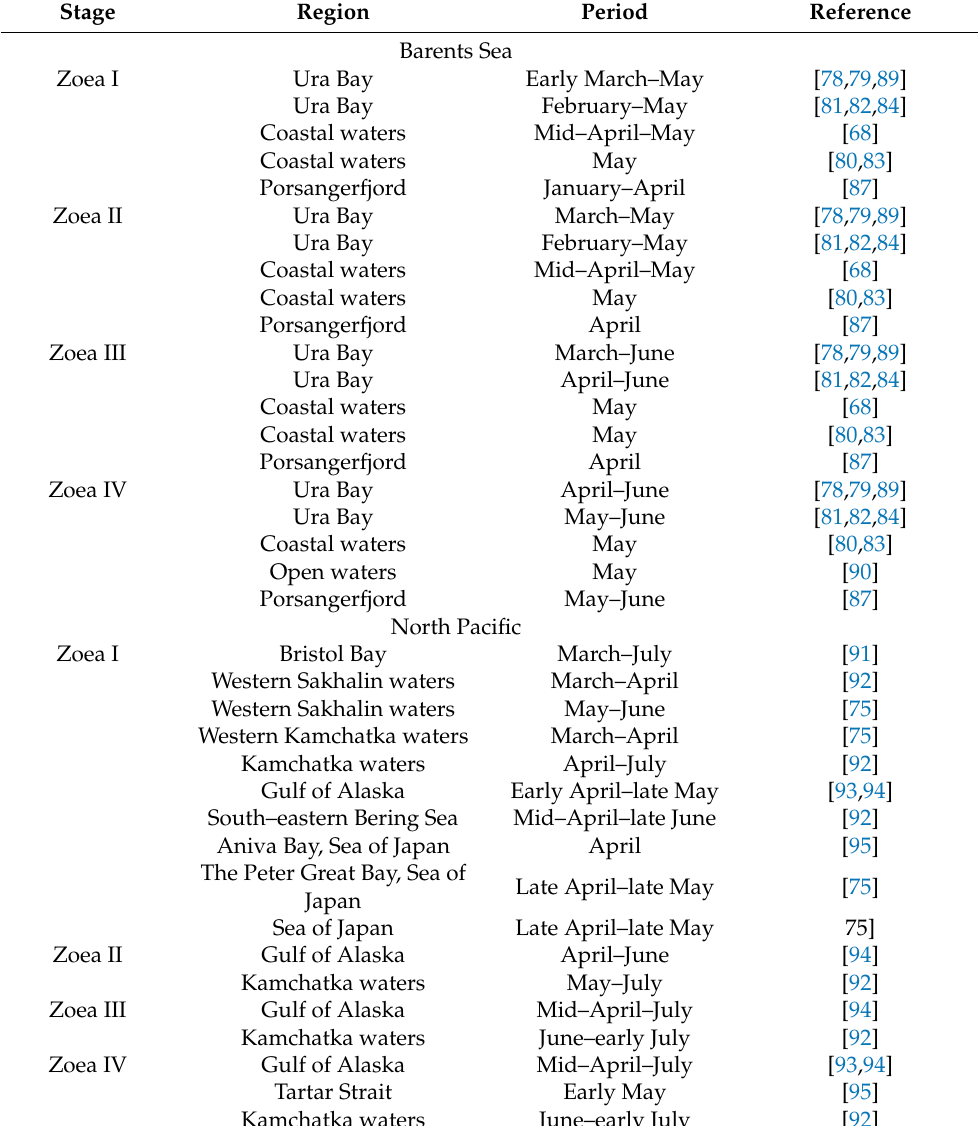
Table 3. Occurrence of red king crab larvae in the plankton of the Barents Sea and the North Pacific